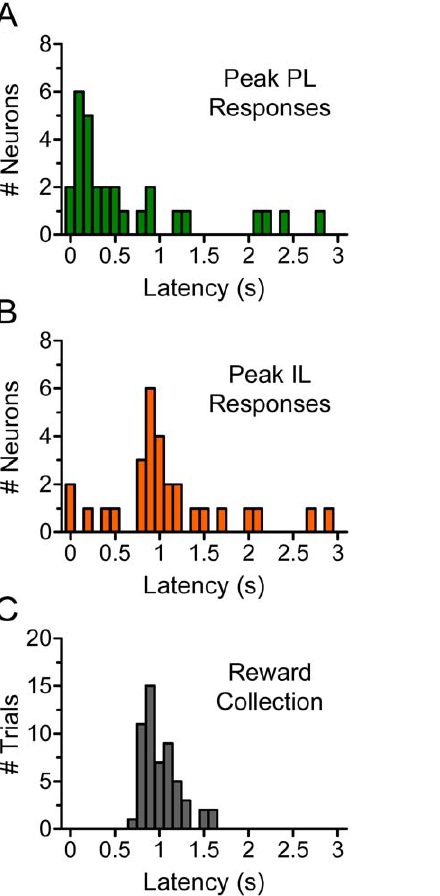
Figure 3. Latencies for PL, IL, and reward collection. The distribution of PL latencies peaked at , 0.1 s after rewarded lever presses were achieved ( A ), whereas the distribution of IL latencies peaked at , 1 s ( B ). Similar to IL, the distribution of latencies for reward collection peaked at , 1 s after rewarded presses were achieved ( C ).